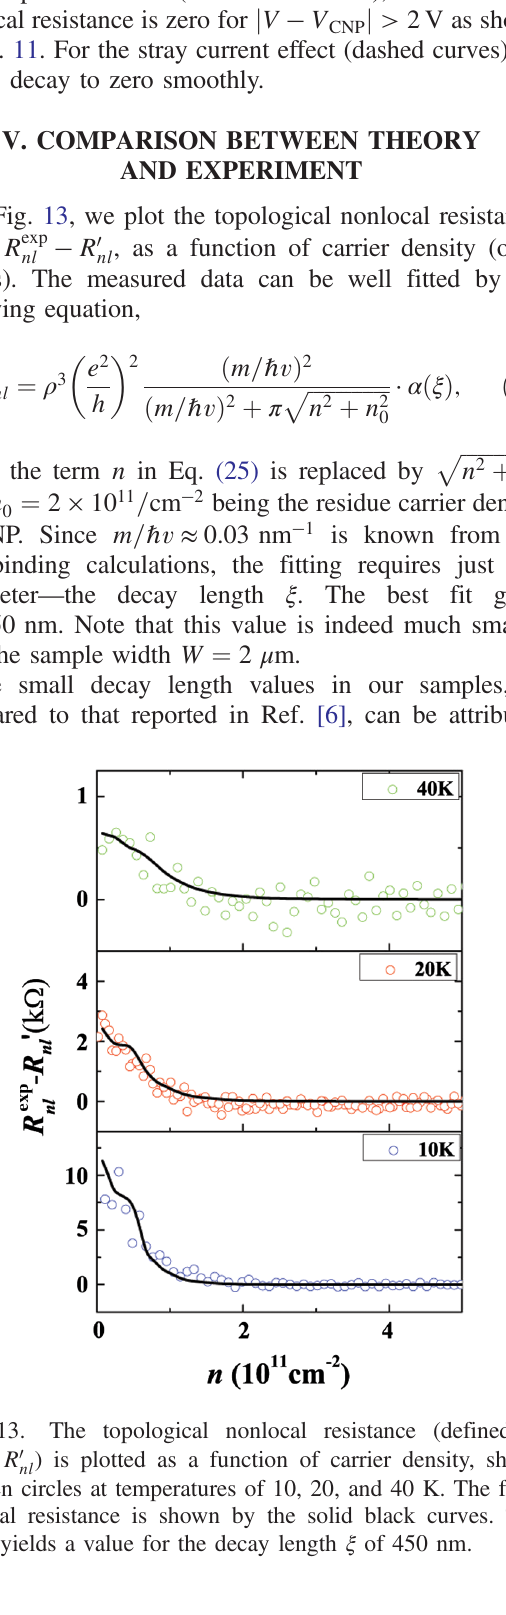
FIG. 13. The topological nonlocal resistance (defined as − R 0 R exp ) is plotted as a function of carrier density, shown nl nl by open circles at temperatures of 10, 20, and 40 K. The fitted nonlocal resistance is shown by the solid black curves. This fitting yields a value for the decay length ξ of 450 nm.